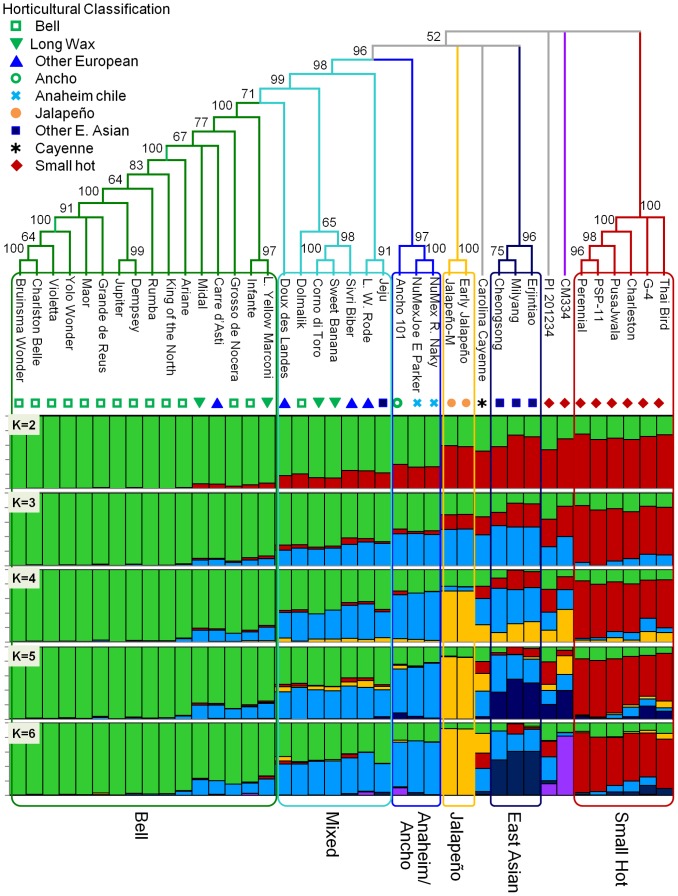
Consensus tree and population substructure estimated from SPP markers.At the top, a Fitch & Margoliash tree of 40 C. annuum lines, rooted with C. frutescens and C. Chinense. The majority-rule consensus cladogram (overall equal branch lengths) was generated from 13,621 SPP markers. Numbers associated with branches indicate percent support based on 7,500 bootstrap replicates. Branches with less than 50% support have been collapsed. At the bottom is shown C. annuum population substructure determined using Structure with 2,712 mapped SPP markers for K = 2 to K = 6. Each genotype is represented by a vertical column and genotypes are ordered according to the cladogram. Each color bar represents a different subpopulation and the proportion of a given variety's color bar represents the proportion that variety belongs to the corresponding subpopulation. The branches of the cladogram are colored according to the highest proportion subpopulation assignment when K = 6 with grey branches indicating highly admixed individuals, having no more than a 0.60 fraction assigned to any subpopulation. Grouping by common structure subpopulation constitution is indicated by colored border with assigned names shown below. Long Yellow Marconi and Lange Westlandse Rode are abbreviated L. Yellow Marconi and L. W. Rode, respectively.